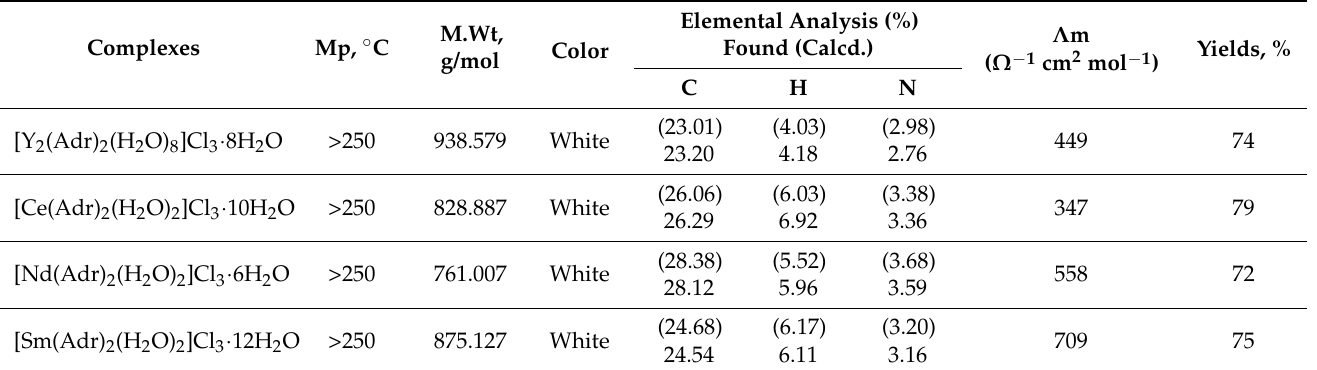
Table 1. Adrenaline adducts: physical characteristics, microanalytical data, and molar conductance data. Complexes Mp, ◦ C